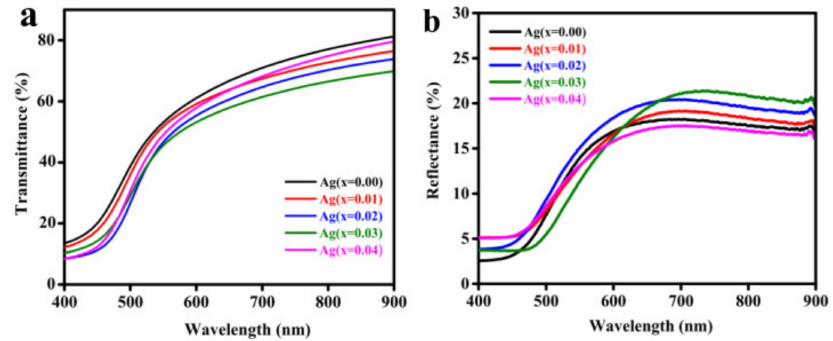
Figure 2. ( a ) Transmittance and ( b ) reflectance spectra of pure and Ag-doped CdO thin